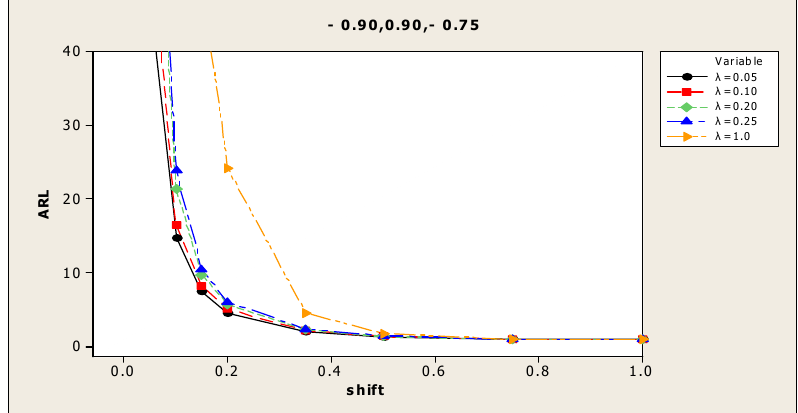
Figure 1. Average run length (ARL) curves when ρ yu = 0.65, ρ yv = 0.30, ρ uv = 0.50 at above values of λ .